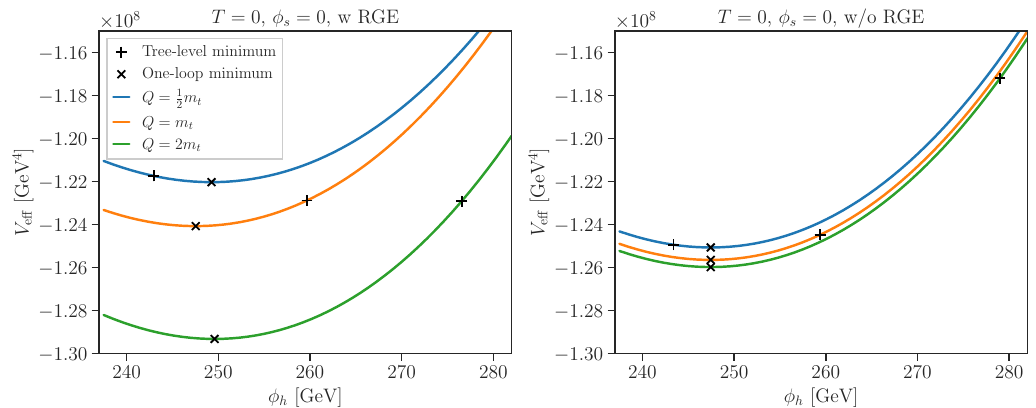
Figure 7 . The zero-temperature effective potential in the MS scheme for the benchmark point in eq. (4.1) at different renormalisation scales, with (left) and without RGE running